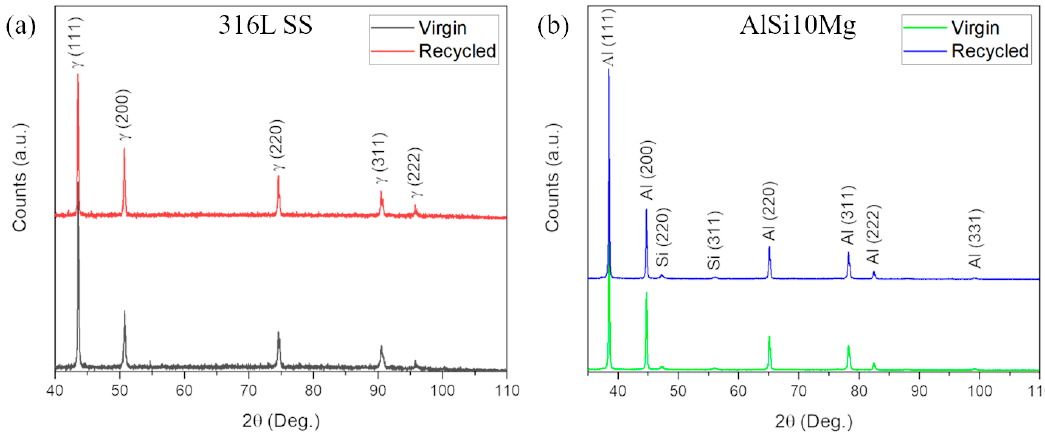
Figure 5. XRD spectra of virgin and recycled 316L SS ( a ) and AlSi10Mg ( b ) powders.